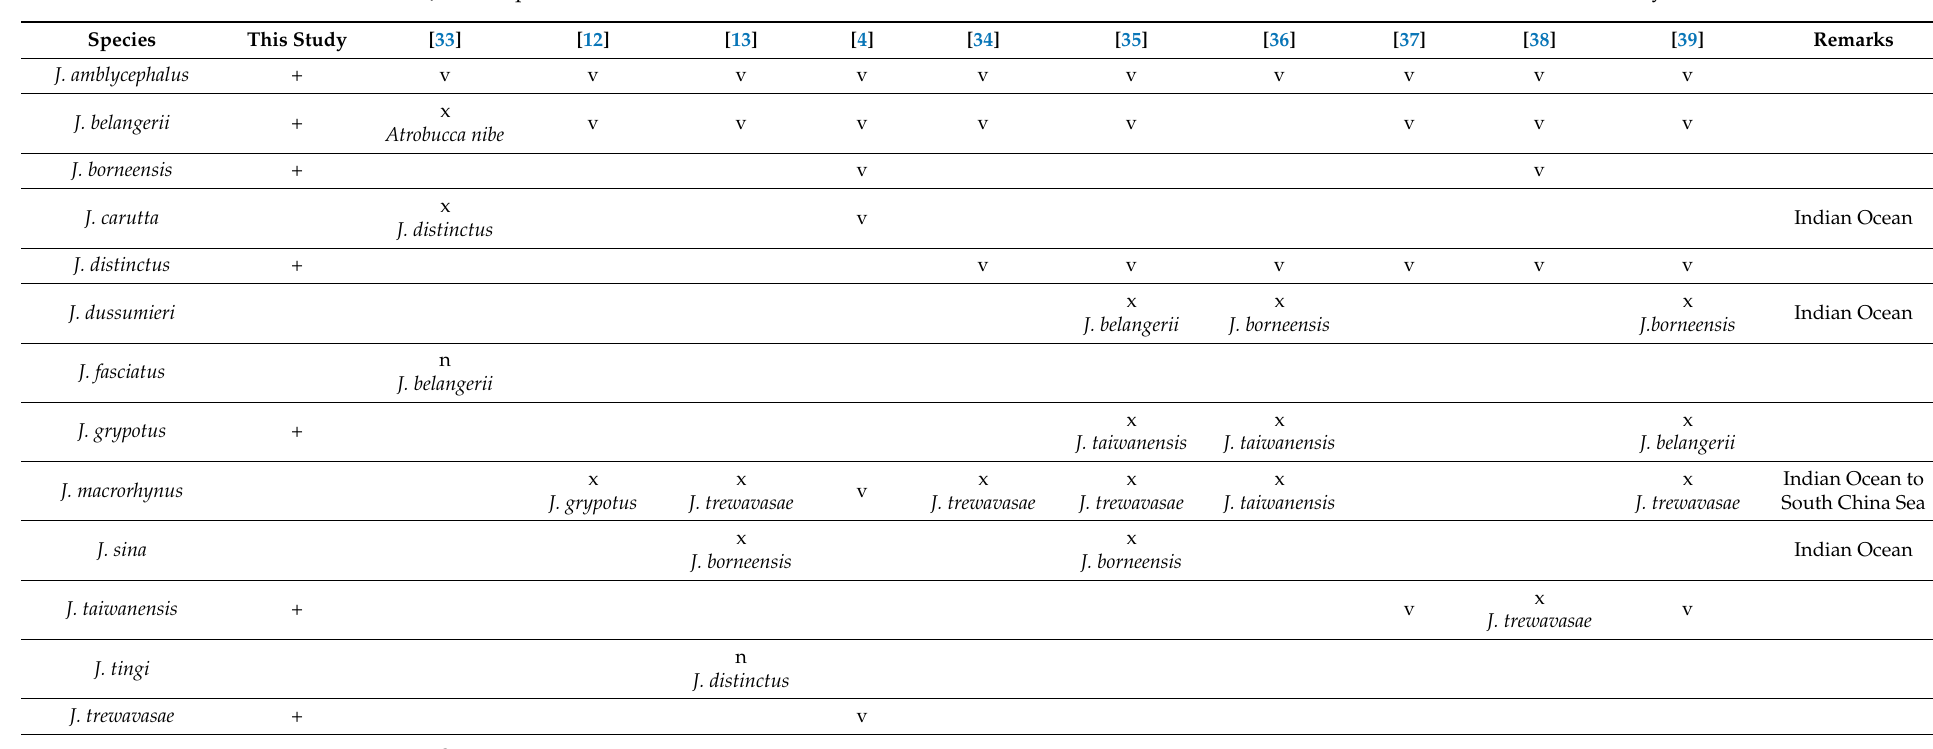
Table 3. Johnius species as listed in several book references from Taiwan, and their taxonomic status. Correct names listed in the body of the